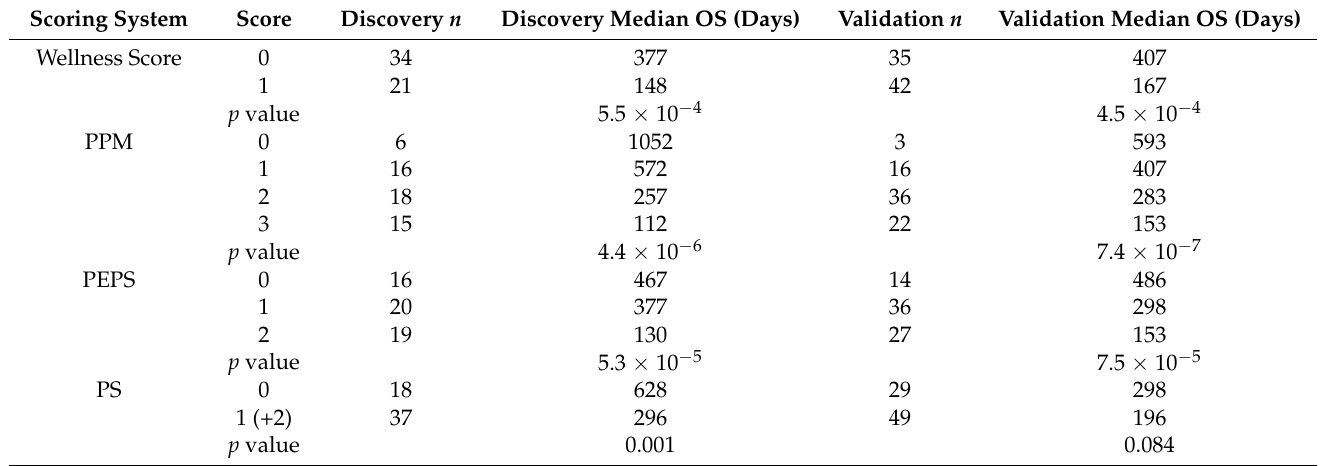
Table 3. Median overall survival (OS) and significance of Wellness Score, Enhanced Proteomics PS score (PEPS), Phase I proteomics score (PPM), and Performance Status (PS) in the discovery and validation